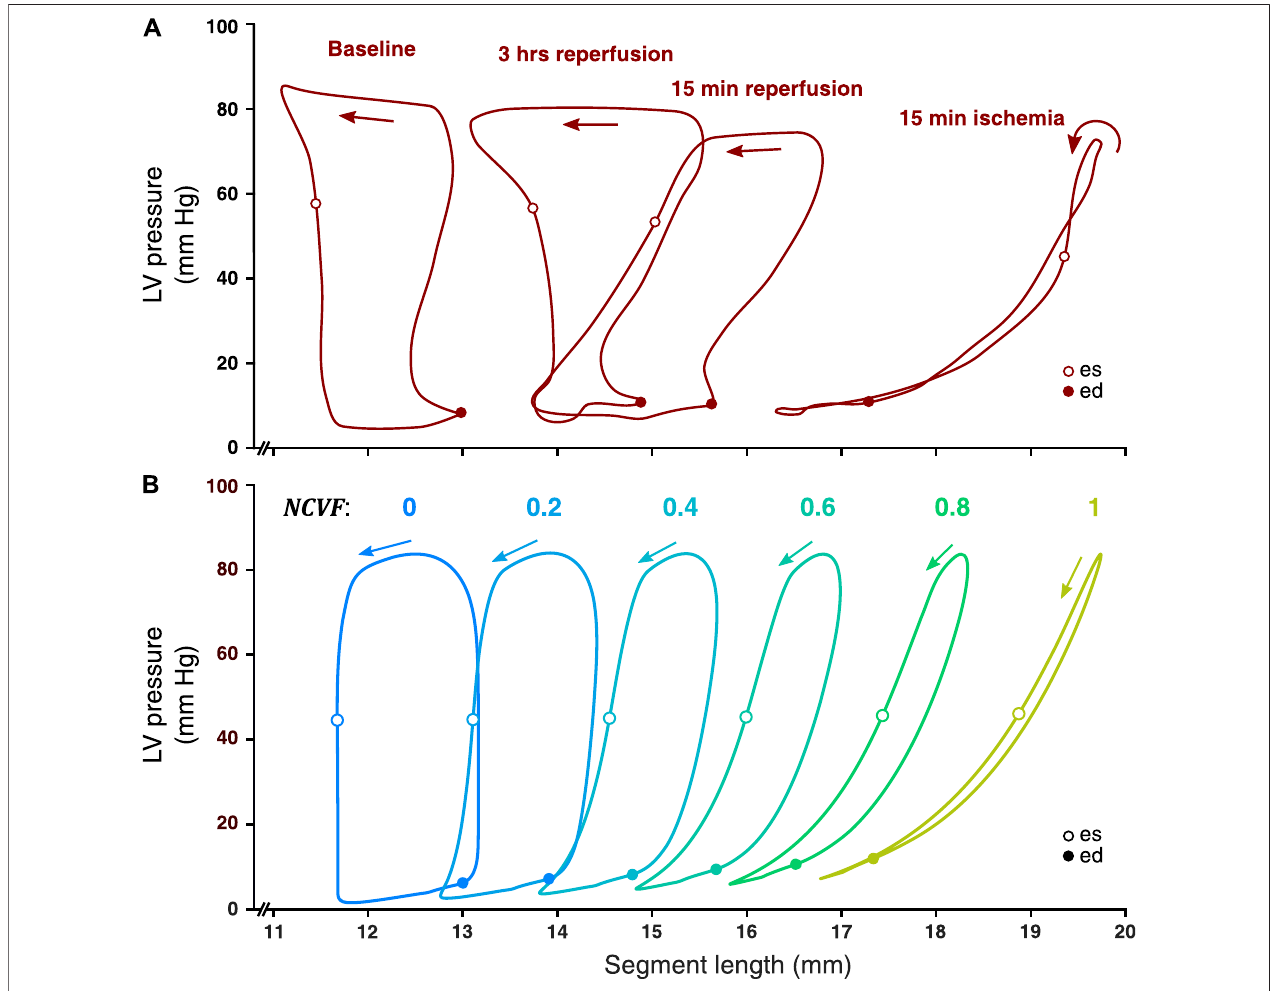
FIGURE 4 | Comparison between measured LV pressure-segment length loops in a representative dog after 15 min of left anterior descending (LAD) coronary arteryocclusion,followedby15 minand3 hofreperfusion[ (A) ,resketchedfromLyseggenetal.(2005)]andsimulatedLVpressure-segmentlengthloops (B) forvarying regional contractile dysfunction ( NCVF ). ed, end-diastole; es, end-systole.